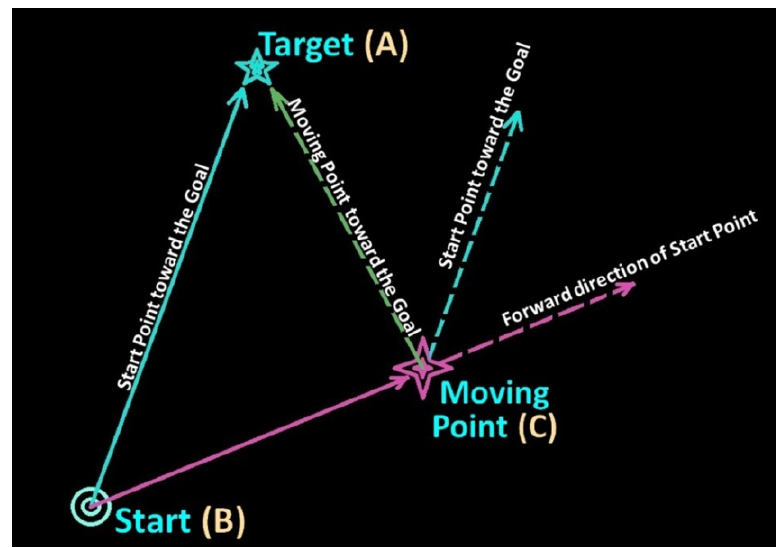
Figure A6. The robot needs to go to the target point from the starting point.